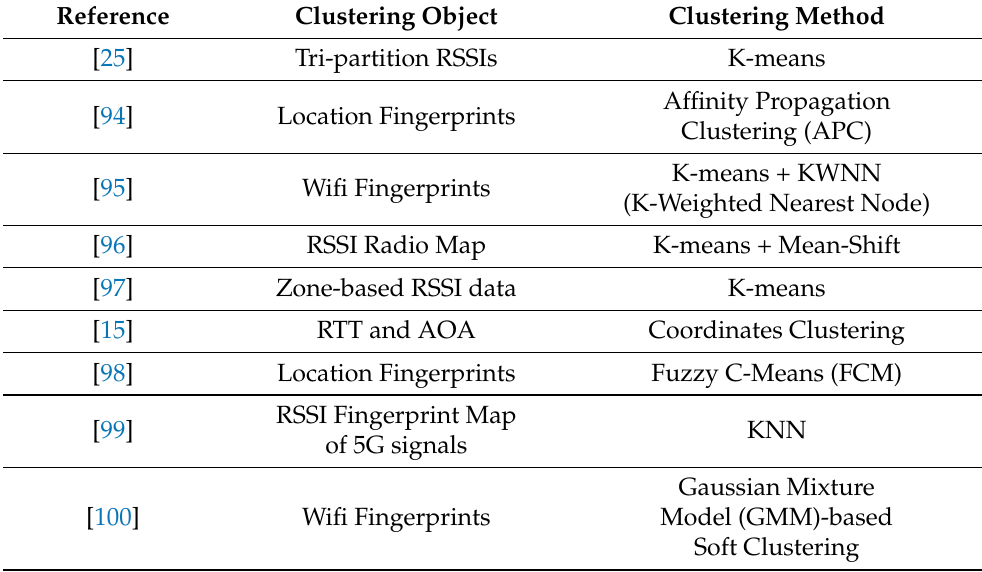
Table 1. Clustering method and the related clustering